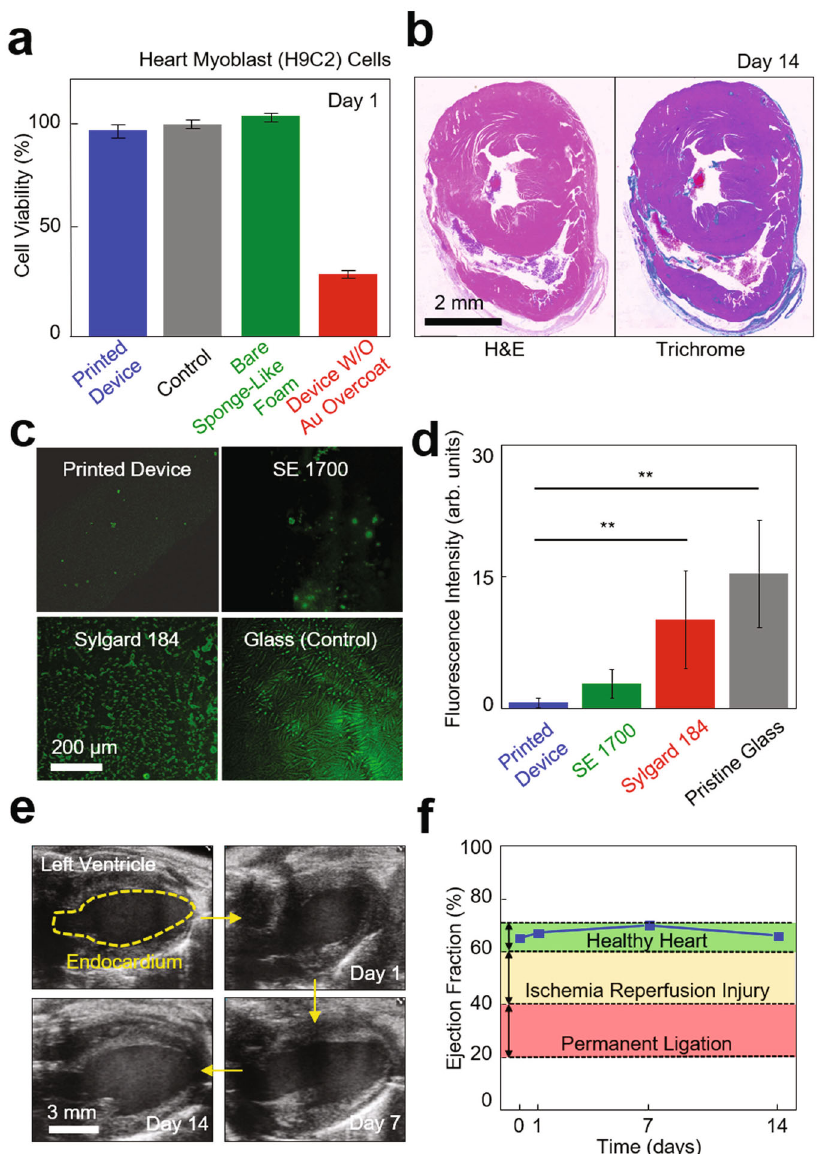
Fig. 6 Evaluation of biocompatibility, anti-biofouling, and effect on cardiac function. a Results of cell compatibility assay for the custom-printed sensor array with heart myoblast (H9C2) cells in a 24-well plate, as measured using a colorimetric assay kit ( n = 3 per group). b Representative histological cross- sectional views of the murine cardiac tissues that were stained with both hematoxylin-eosin (H&E; left panel) and Masson ’ s trichrome (MTC; right panel) on day 14 post-implant of the custom-printed sensor array. c Z-stack fl uorescence images of a BSA-FITC (6 mg/ml) coated on the printed device as compared to control groups made of the SE 1700 ink and the Sylgard 184 ink and prepared on a pristine glass, from upper left to bottom right clockwise. d Results of one-way ANOVA tests with Bonferroni correction ( n = 5 per group). Fluorescence intensity of pristine glass and sylgard 184 is shown as average ± standard deviation ( ** p = 3.4 × 10 − 7 , 4.1 × 10 -4 ), versus printed device. e Representative ultrasound images of the left ventricle of a murine heart on 0, 1, 7, and 14 days implantation of the custom-printed sensor array. f Results of the ejection fraction of the murine heart